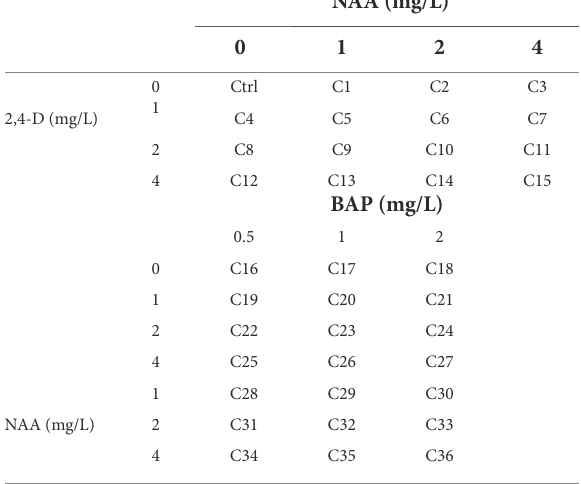
TABLE 1 Combinations of auxins and cytokinin used in initiation media with leaf and stem explants.